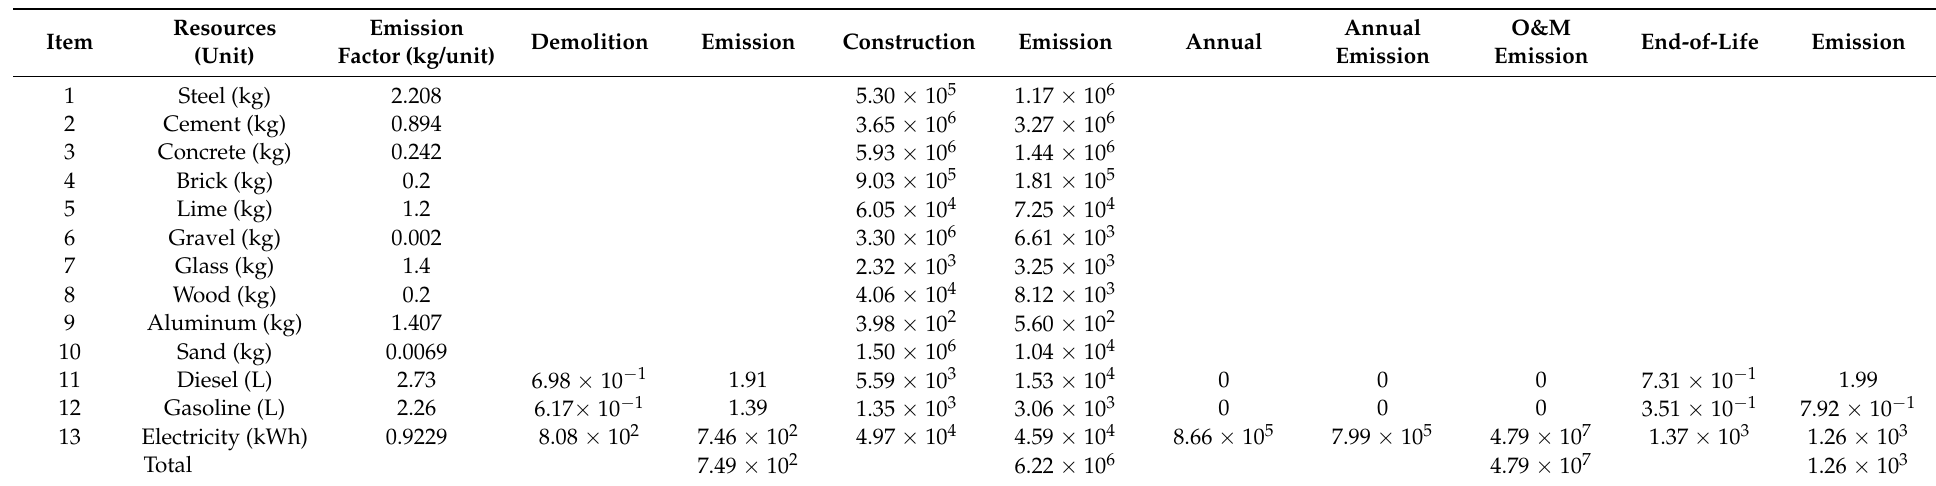
Table 6. CO 2 emissions in the rebuilding strategy.